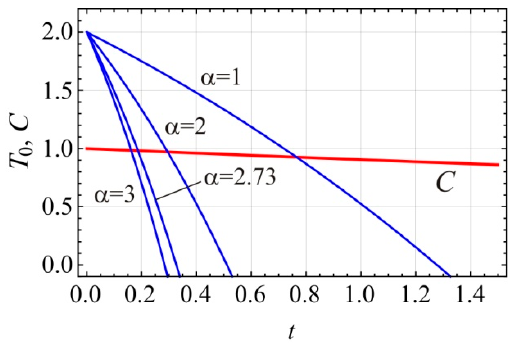
Figure 3. Amplitude C (red line) and string force T 0 (blue line) versus time t for various values of nonlinearity order α . Table 1. Absorption parameters versus nonlinearity.